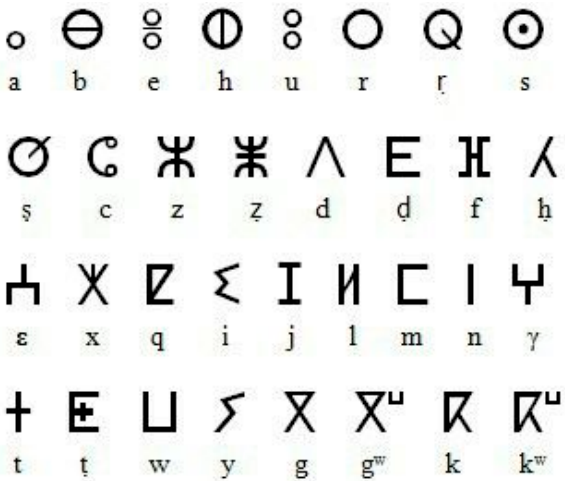
Figure 2. Tifinagh symbols and Neo-Tifinagh alphabet. The lowercase letters represent the orthography in Latin script with diacritics indicating specific Amazigh phonemes.